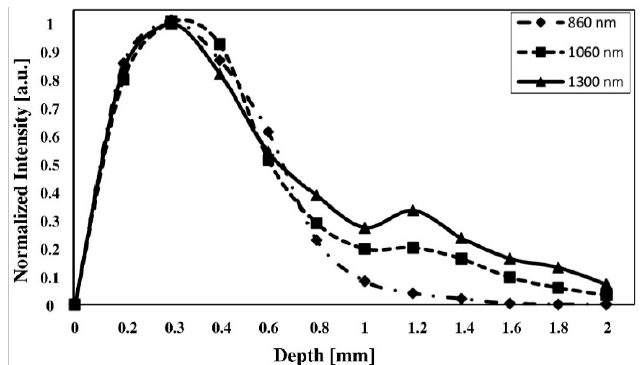
Figure 5. Depth profile comparison between multiple wavelength OCT systems in terms of normalized total intensity.